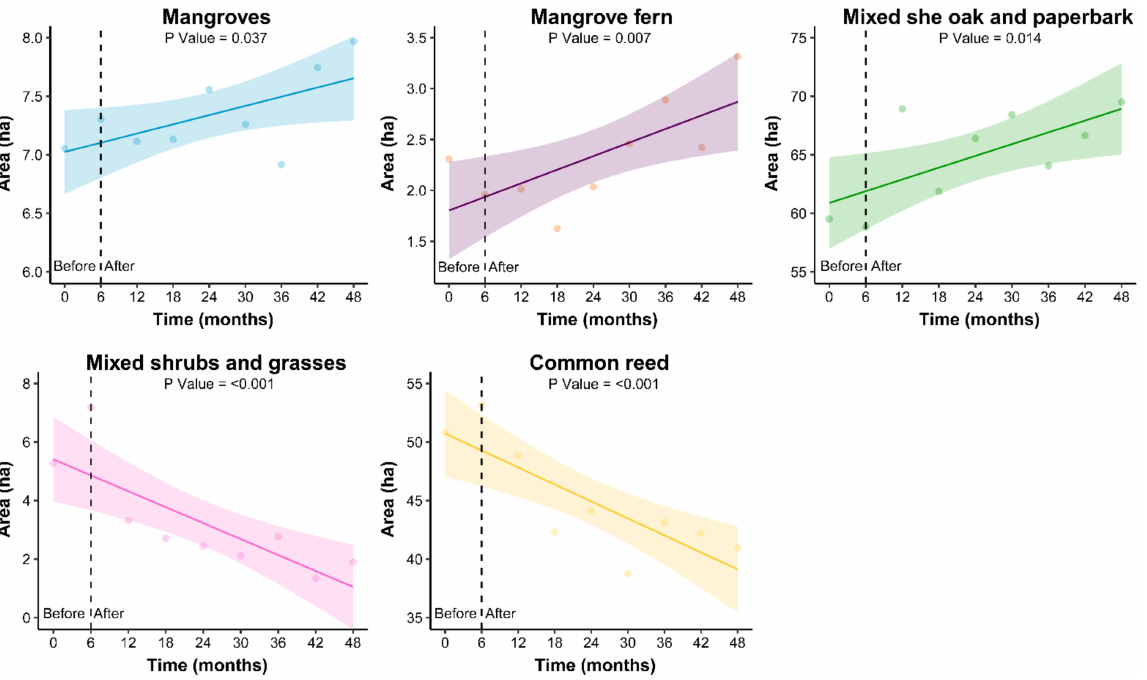
Figure 7. Generalized linear models (GLMs) illustrating changes in the area of wetland vegetation classes over a period of 48 months, between spring 2017 and 2021. Restoration commenced with the removal of tidal obstructions 6 months after the start of this monitoring